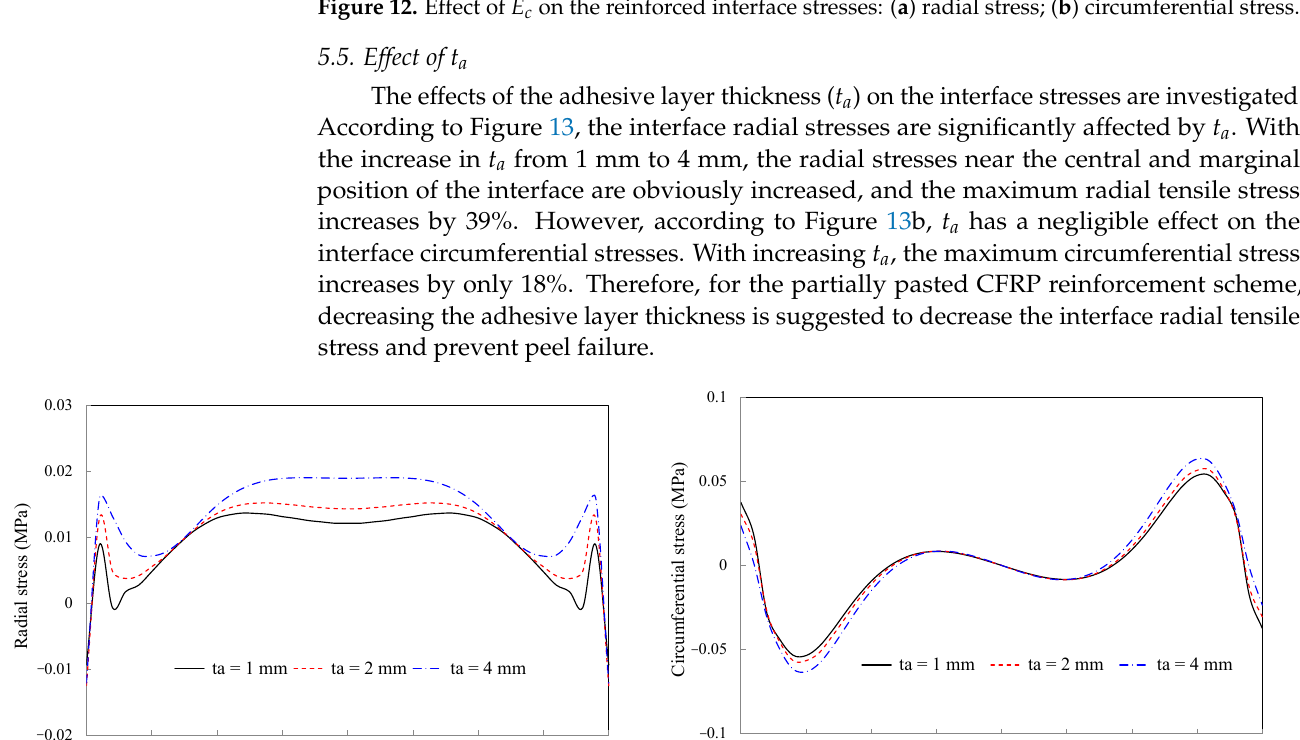
Figure 12. Effect of E c on the reinforced interface stresses: ( a ) radial stress; ( b ) circumferential stress.